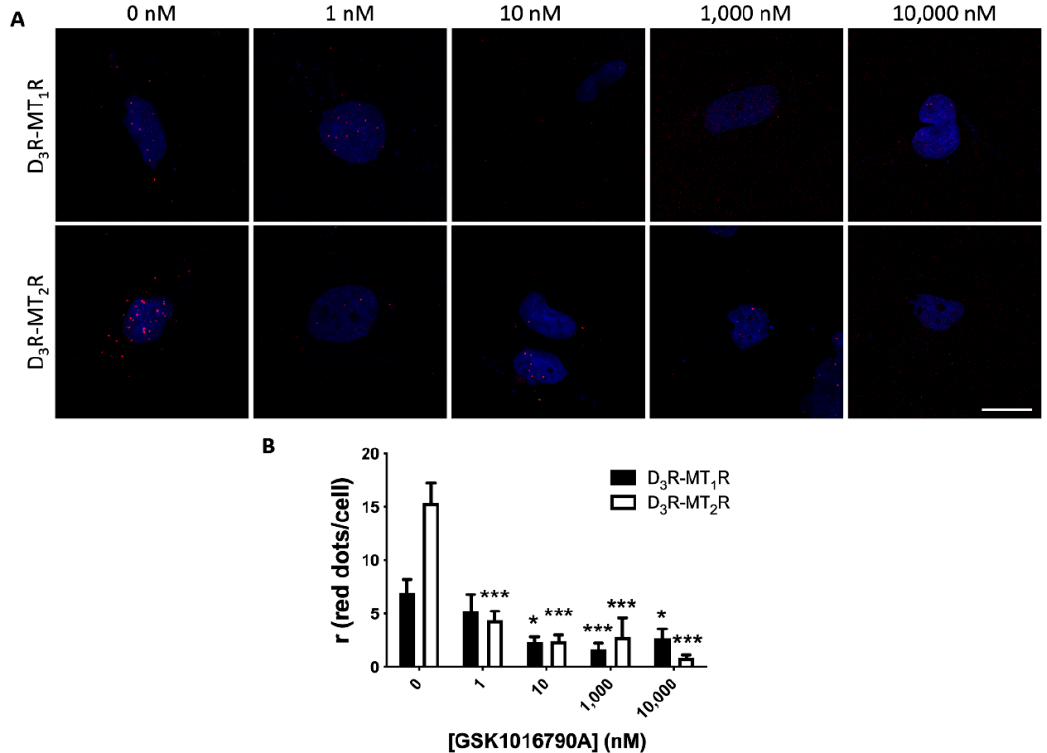
Figure 3. D 3 -MT 1 and D 3 -MT 2 heteroreceptor expression in human 59HCE cells. Proximity ligation assay (PLA) was performed as described in Methods to detect D 3 -MT 1 and D 3 -MT 2 receptor complexes in the 59HCE non-pigmented ciliary body epithelial cell line, using specific antibodies against D 3 and either MT 1 or MT 2 receptors. ( A ) Cells were treated with different concentrations of GSK1016790A, a TRPV4 agonist. Representative images corresponding to stacks of 5 sequential planes are shown. Cell nuclei were stained with Hoechst (blue) and heteroreceptor clusters appear as red dots. ( B ) Ratio (r; number of red spots/cell-containing spots) is the mean ± S.E.M. of counts in 5 different fields from every sample (n = 5). One-way ANOVA followed by Bonferroni’s multiple comparison post-hoc test were used for statistical analysis. (* p < 0.05, *** p < 0.001; versus 0 nM GSK1016790A). Scale bar: 20 μ m.